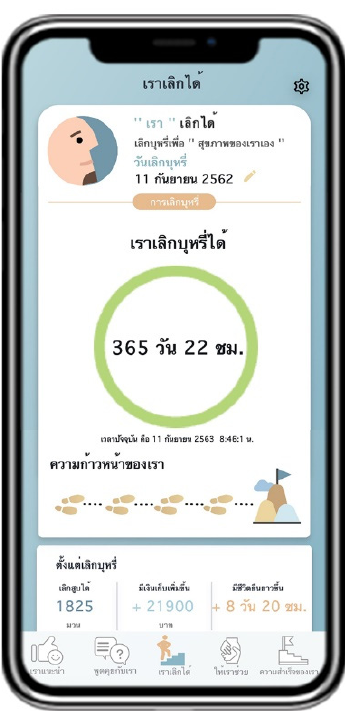
Figure 4. Display screen of Quit with US.